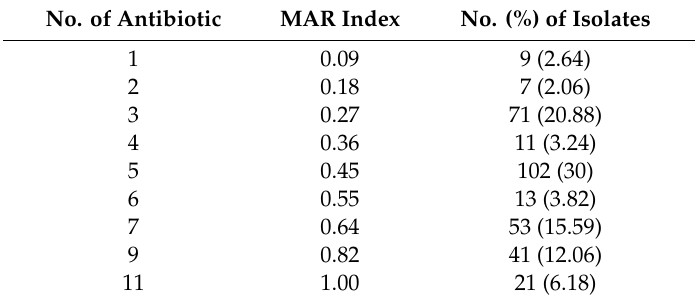
Table 4. Multiple antibiotic resistance (MAR) indices of Escherichia coli